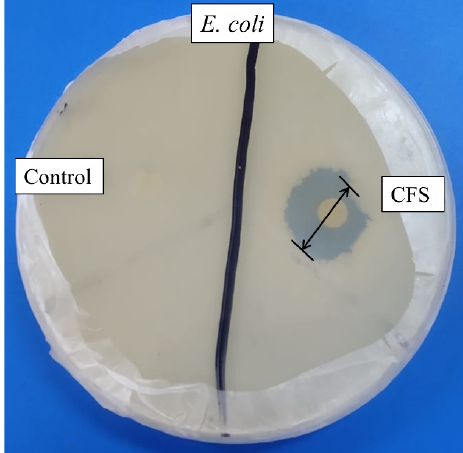
Figure 1. Antibacterial activity of cell-free supernatant (CFS) against E. coli . The MRS broth was used as negative control, while the disk diameter was 6 mm.